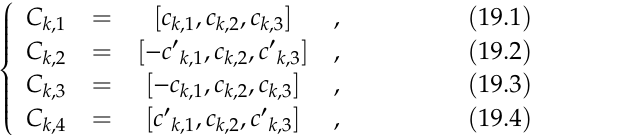
C , C . (a) For c locates at the left side of Figure 2. Four different possible results of Figure 2. Four di ff erent possible results of C k . ( a ) For C k ,1 , c 3 locates at the left side of ξ k . ( b ) For C k ,2 , ,1 k k 3 c 3 locates at the right side of ξ k . ( c ) For C k ,3 , c 1 is perpendicular to the plane c 2 Oc 3 and downward. C , C , c locates at the right side of c is perpendicular to the plane  . (c) For ,2 k ,3 k k 3 1 ( d ) For C k ,4 , c 1 is perpendicular to the plane c 2 Oc 3 and C , c Oc and upward. c is perpendicular to the plane downward. (d) For ,4 k 2 3 1